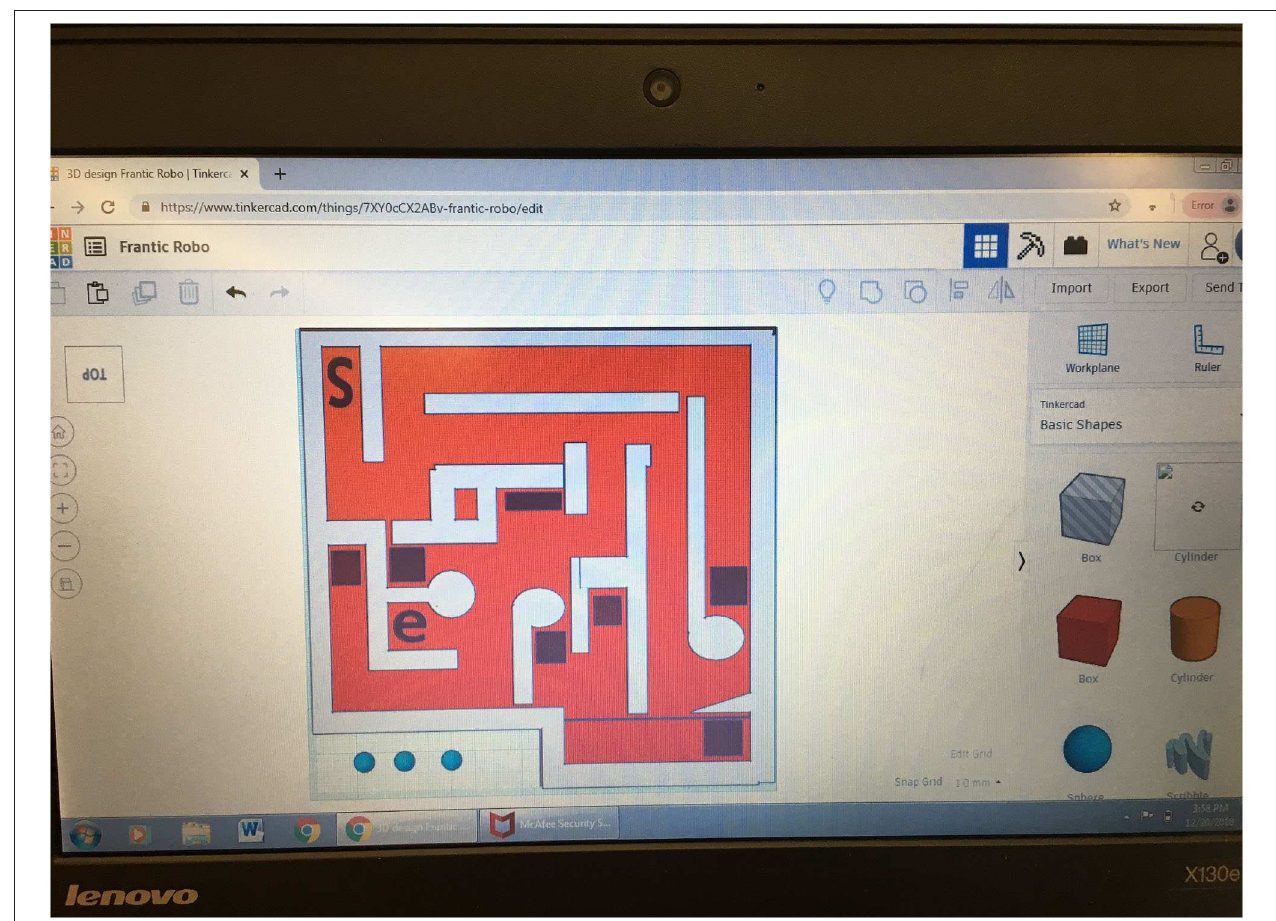
FIGURE 9 | Tinkercad Maze.